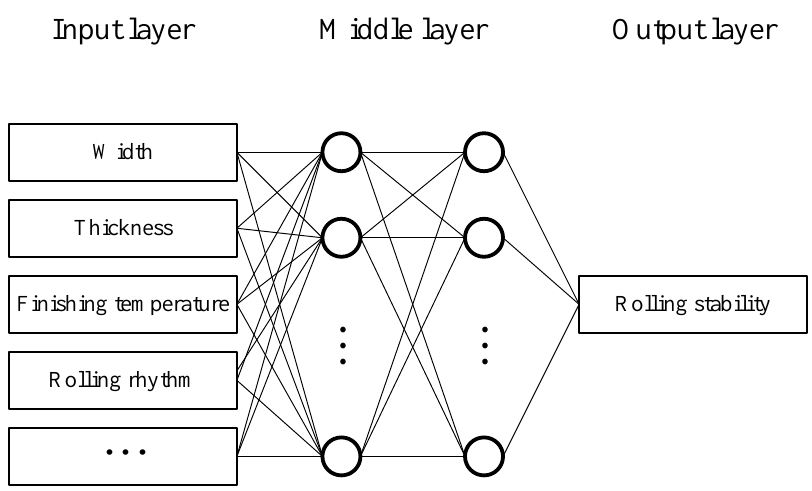
Figure 2. Neural network model of limit gauge